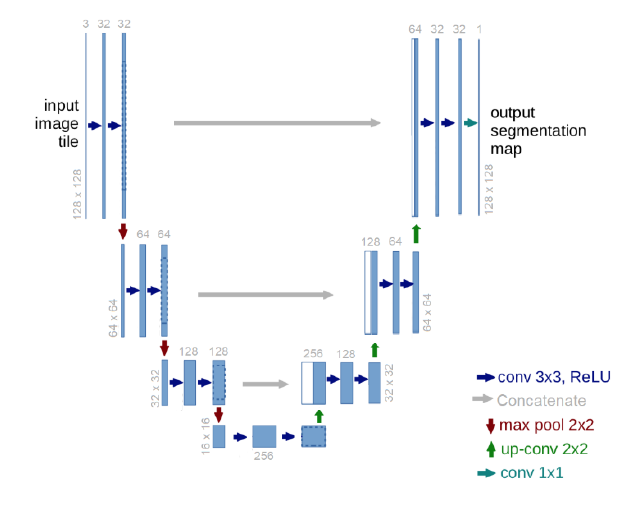
Figure 2 . A sample of a pair of a training image and corresponding label with white as tree crowns. Figure 3 . The U-net architecture used in this